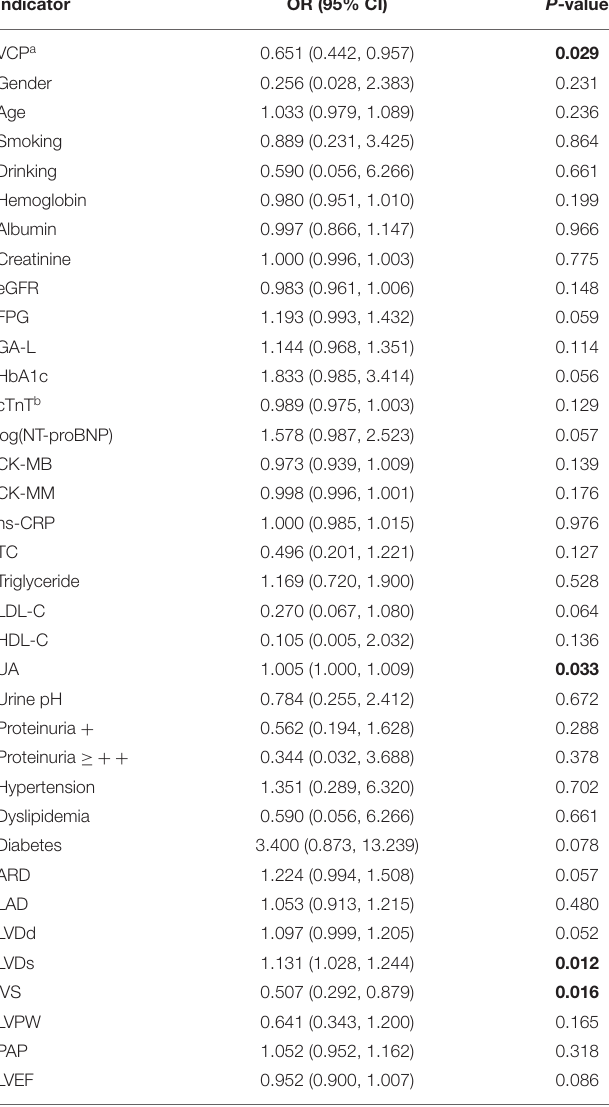
TABLE 6 | Risk factors for VD in patients with ACS evaluated by multivariate logistic stepwise regression analysis (all indicators increase by 1 unit unless otherwise